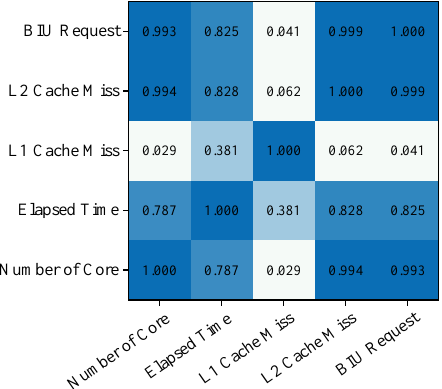
Figure 14. Correlation by measurement